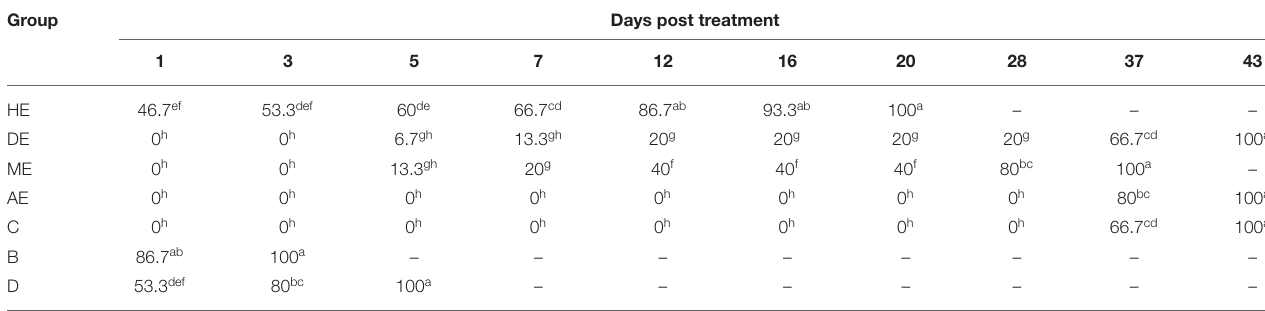
TABLE 1 | In vitro mortality rates of engorged Hyalomma dromedarii treated with 5% hexane, methanol, dichloromethane, and aqueous extracts of neem seeds in comparison to some synthetic chemical materials (Butox 5%, Diazinon-60). Group Days post treatment